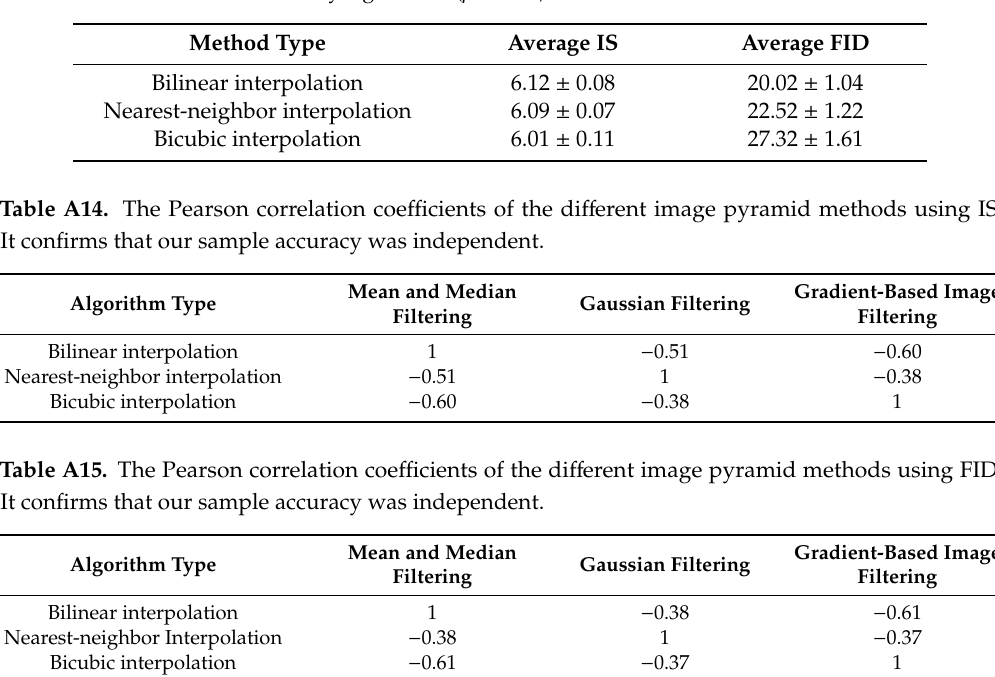
Table A13. We compared the IS and FID of di ff erent image pyramid methods. We compared the bilinear interpolation, nearest-neighbor interpolation, and bicubic interpolation. The edge-smoothing algorithms we used was mean and median filtering. We gathered statistics for 10 training exercises, and the di ff erence was statistically significant ( p < 0.05).